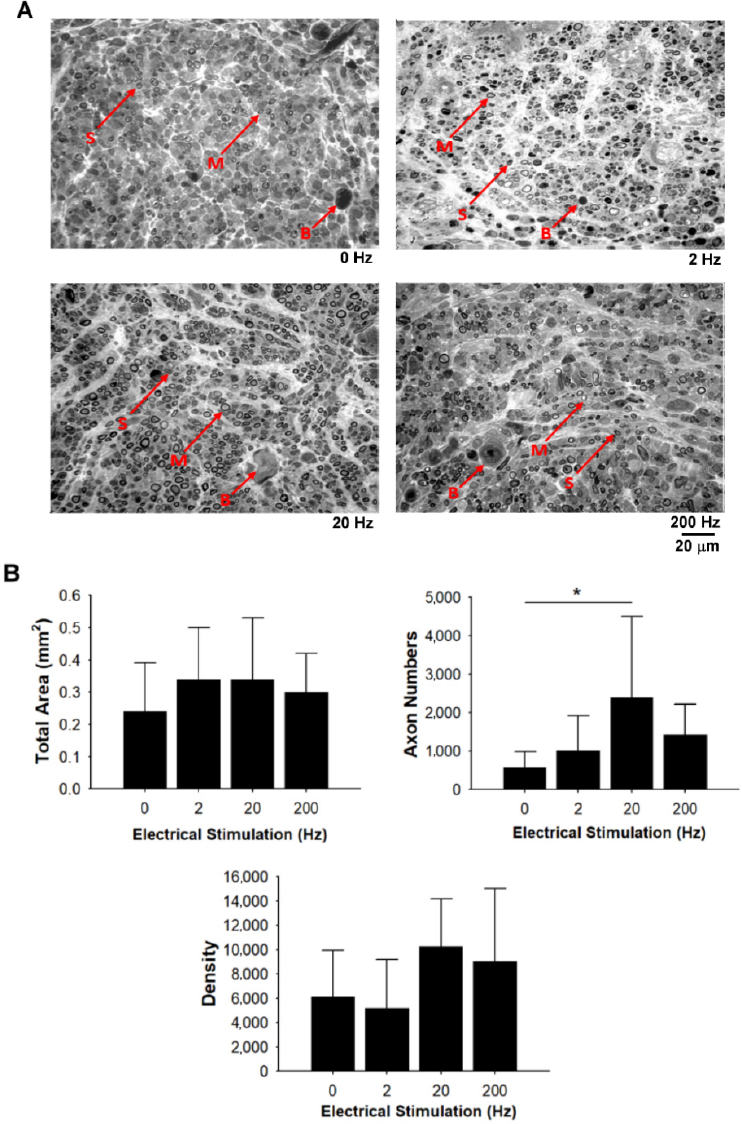
Figure 7. E ff ects of electrical stimulation on axon regeneration in taxol-treated rats. ( A ) Representative micrographs of nerve tissues including myelinated axon (M), blood vessel (B), and Schwann cell (S). ( B ) Morphometric comparisons of regenerated nerves. * Significant di ff erences between conditions, P < 0.05. Scale bar = 20 μ m.